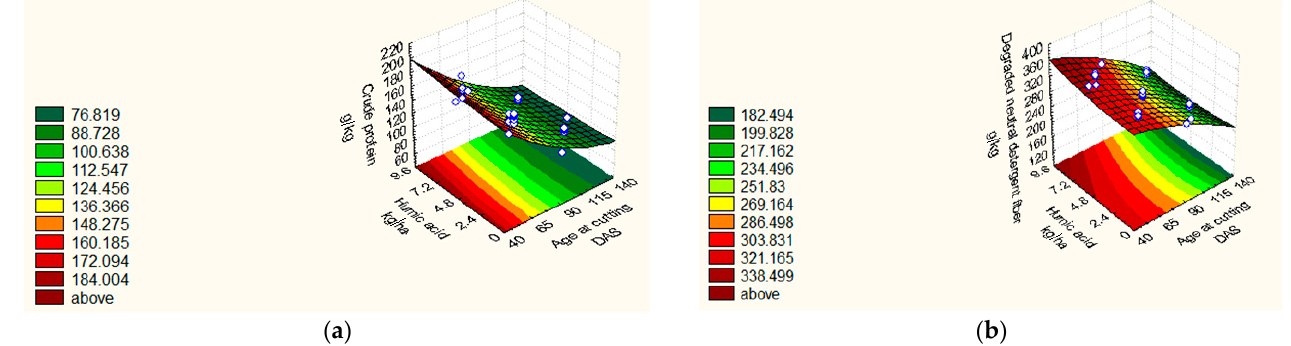
( c ) as affected by AA and AC at the central levels of PF and HA in 2018/19.